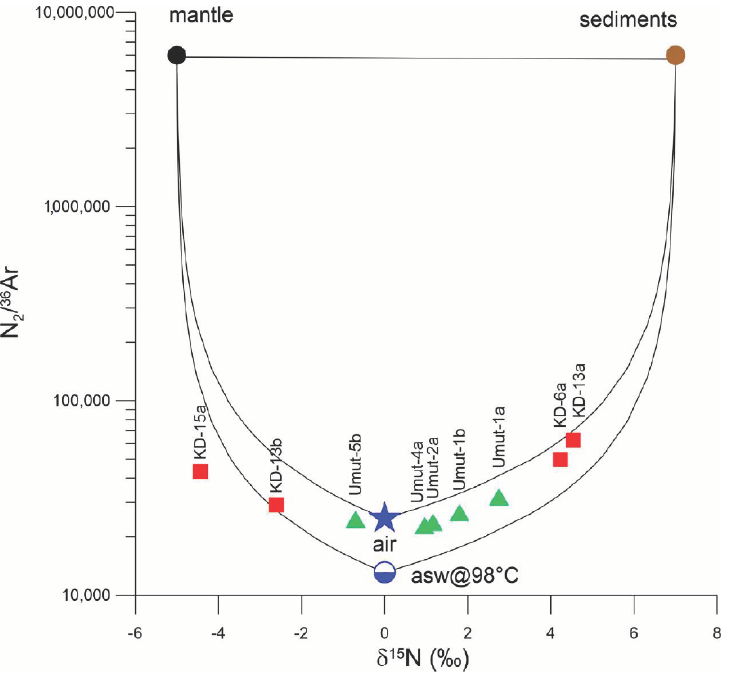
Figure 6. N 2 / 36 Ar ratios vs. δ 15 N diagram, with possible endmembers air, air-saturated water (asw@98 ◦ C = air-saturated water at 98 ◦ C. The N 2 / 36 Ar ratio in air-saturated water is lower than in air, which is due to the higher solubility of argon in water compared to nitrogen), mantle, and organic-rich sediments (modified from [54]). Most Kızıldere and all Tekke Hamam gas samples fall inside a mixing zone of both atmospheric endmembers and one deep endmember. Kızıldere samples: red squares, Tekke Hamam samples: green